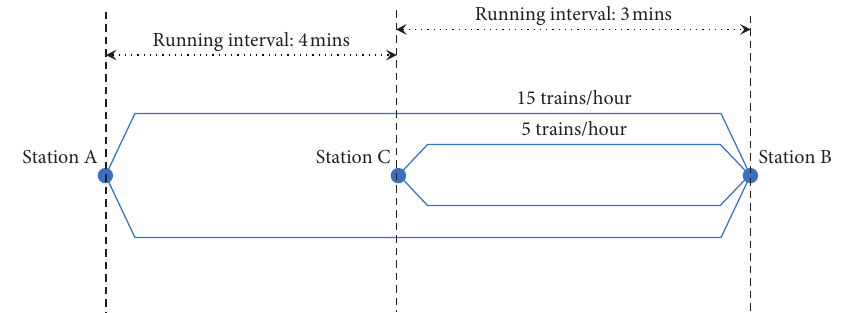
Figure 5: Long-short routing operation mode.